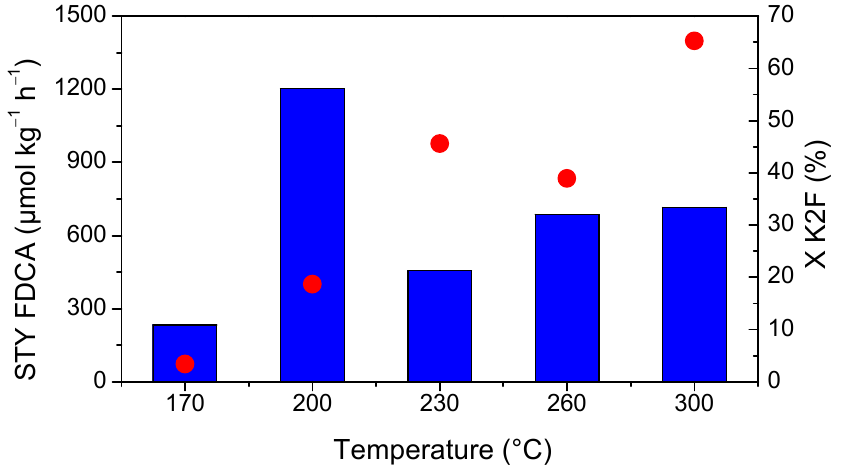
Figure 6. Influence of the reaction temperature on the catalytic performance of Ag/SiO 2 with the conversion of K2F ( ● ) and the STY of 2,5-FDCA ( ■ ). (Conditions: Substrate/Ag = 9, F CO 2 = 45 mL min − 1 , 20 rpm, T = 170–300 °C, t = 20 h.)